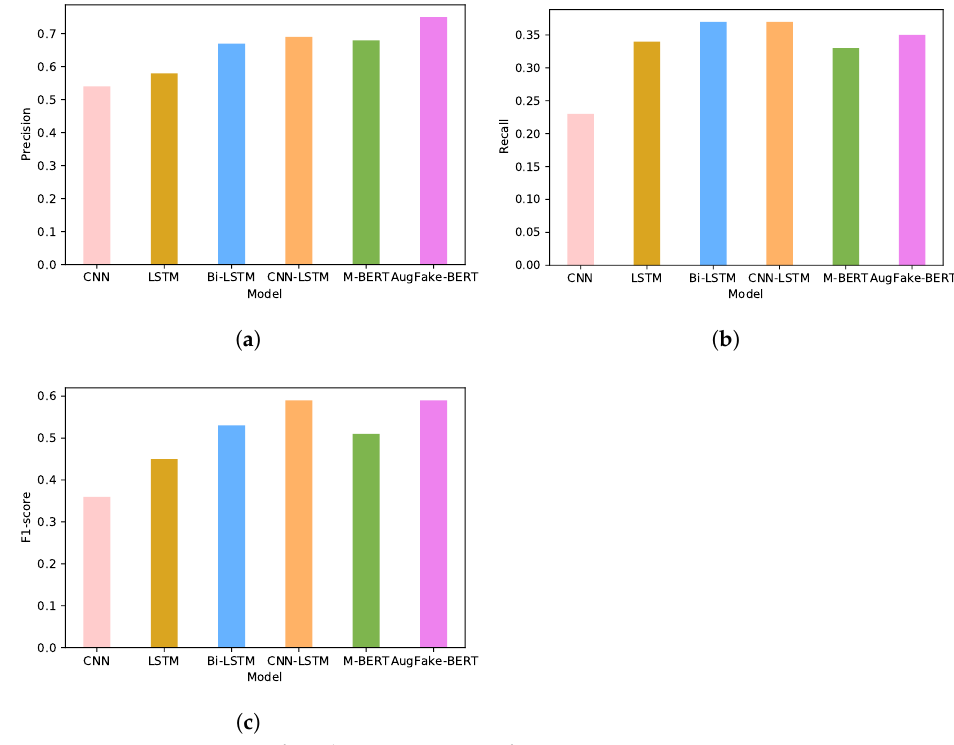
Figure 11. Comparison of evaluation metrics of CNN, LSTM, Bi-LSTM, CNN-LSTM, M-BERT, and AugFake-BERT models on the original dataset. ( a ) Precision; ( b ) Recall; ( c ) F1-score. Table 12. Accuracy, precision, recall, and F1-score on the augmented dataset of deep learning